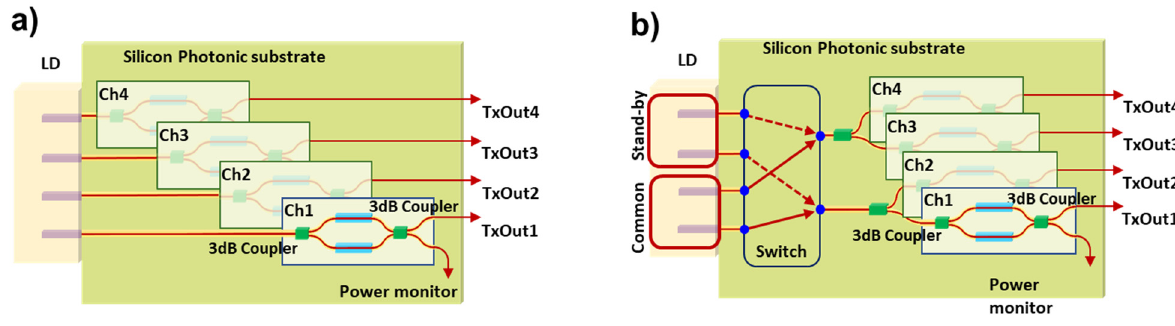
Figure 8. IOCore laser redundancy circuit: ( a ) conventional silicon photonic circuit scheme with single QD-LD array with four optical outputs; ( b ) second-generation IOCore micro-transceiver with two QD-LD arrays, each with two CW optical outputs [3] .